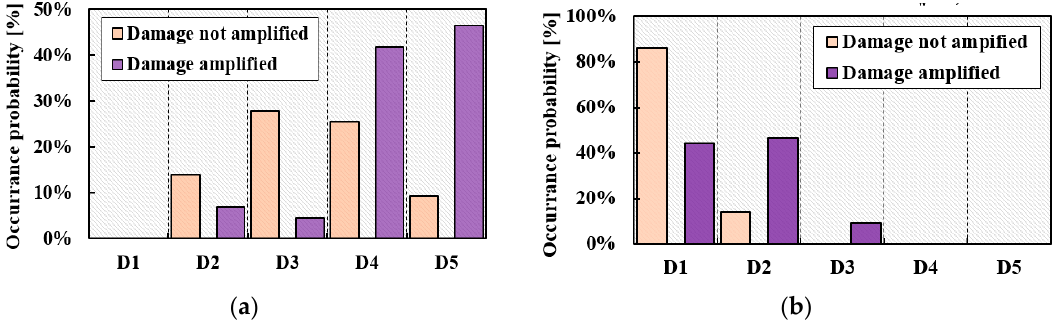
Figure 15. The damage scenarios with and without local seismic effects: comparison of results for M w = 5 and R = 5 Km ( a ) and M w = 5 and R = 20 Km ( b ).